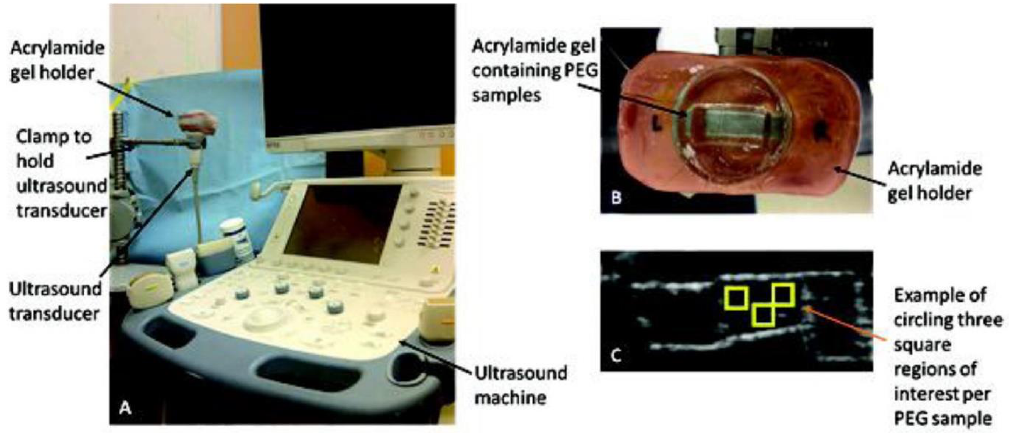
Figure 7. ( A , B ) Experimental setup of ultrasound used to image different areas of a scaffold made of PEG hydrogel. ( C ) Example of output image from the system. Reproduced with permission from Ref. [96]